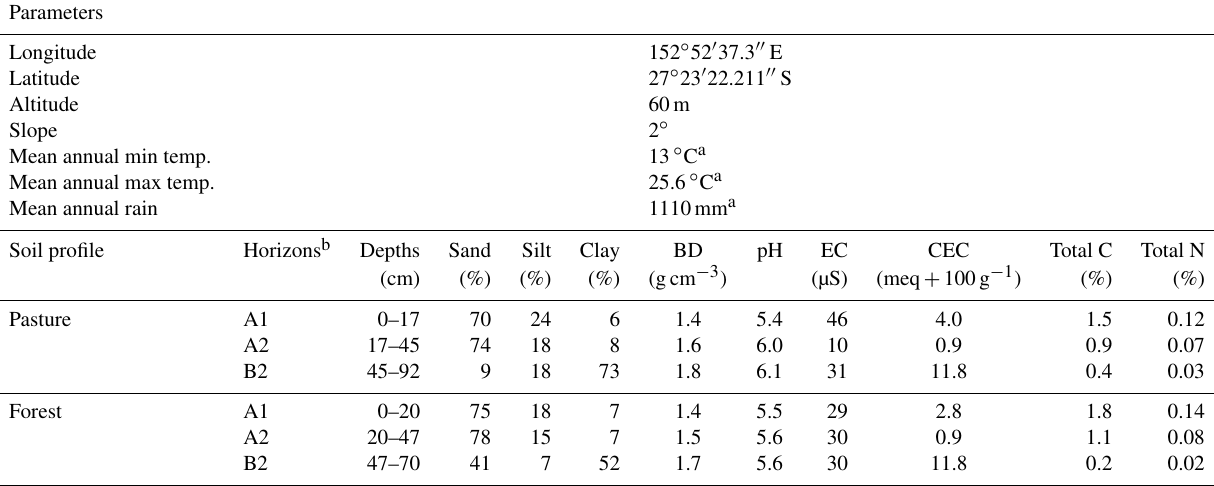
Table 1. SERF site characteristics. Parameters